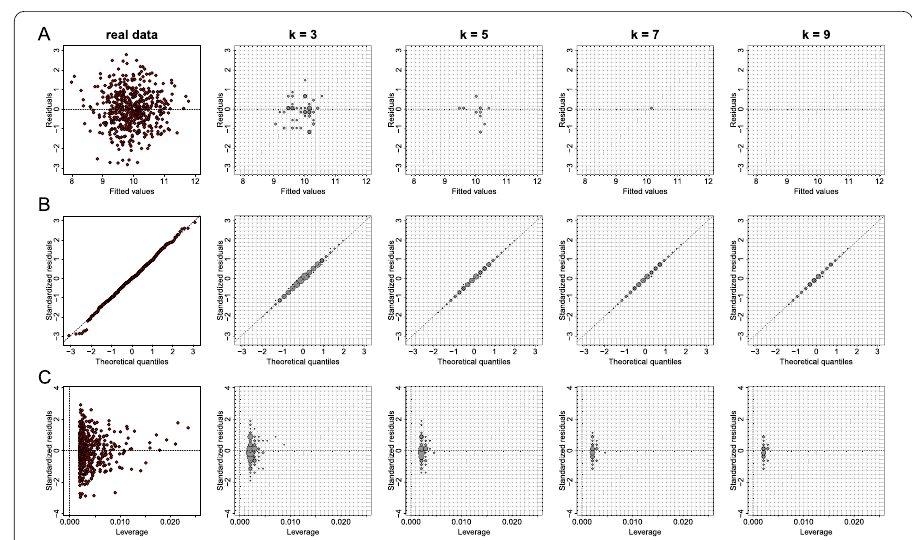
Figure 10 The effect of parameter k of the k -anonymization method on regression plot diagnostics. From left to right we demonstrate the effect of k for the values of 1 (this is equivalent to the real data), 3, 5, 7 and 9 on generating privacy-preserving residuals vs fitted values plots ( A ), normal QQ plots ( B ), and standardized residuals vs leverage ( C )